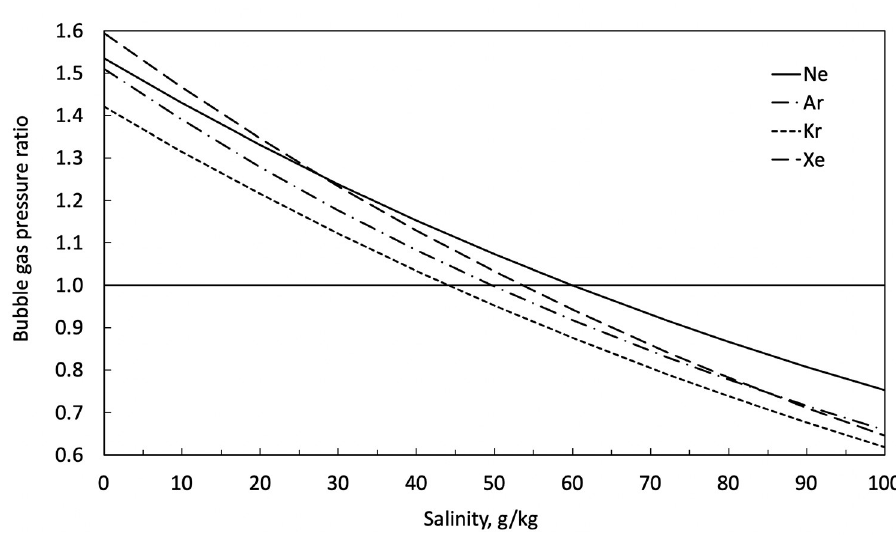
Fig 7. The bubble gas pressure ratio is the measured partial pressure in the bubbles for each gas divided by the computed partial pressure in the bubble based on the measured salt concentration in the spring water. This is plotted for each gas as a function of salinity. As the salinity increases, the solubility of gases decreases. The bubble gas pressure ratios are ~0.8 at the measured values for salinities near the level in the springs (72 g/kg), indicating that the gas in the bubbles is 20% lower than the equilibrium–the gases do not fully achieve equilibrium with the dissolved gases.